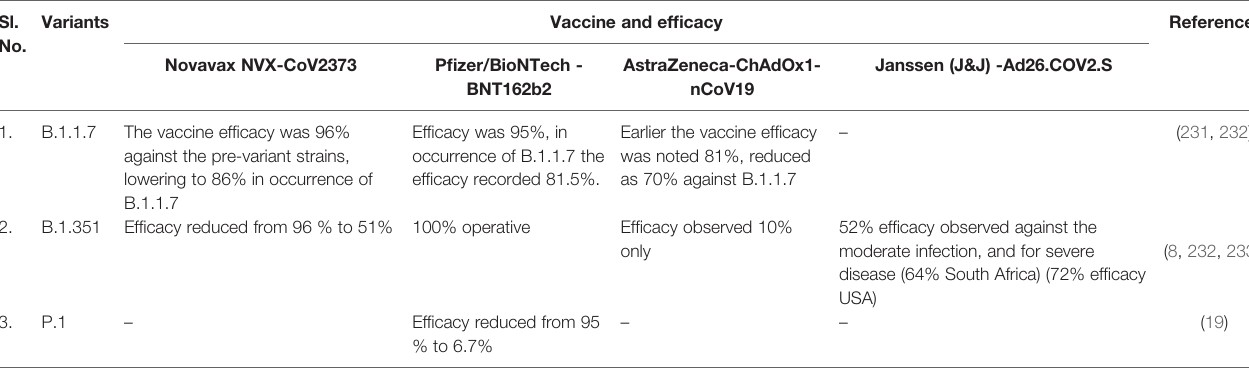
TABLE 5 | Vaccine ef fi cacy against the SARS-CoV-2 signi fi cant variants. Sl. No.